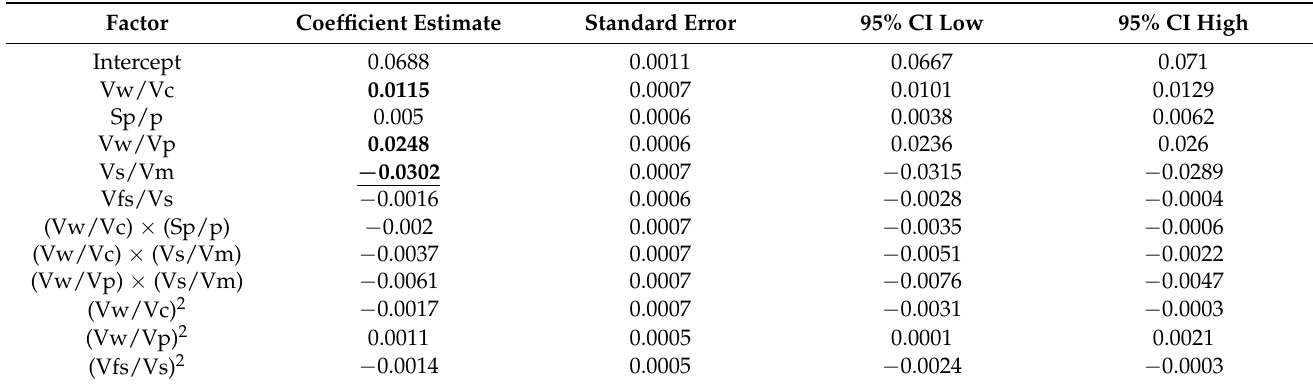
Table 8. T-funnel model coefficients (coded values).